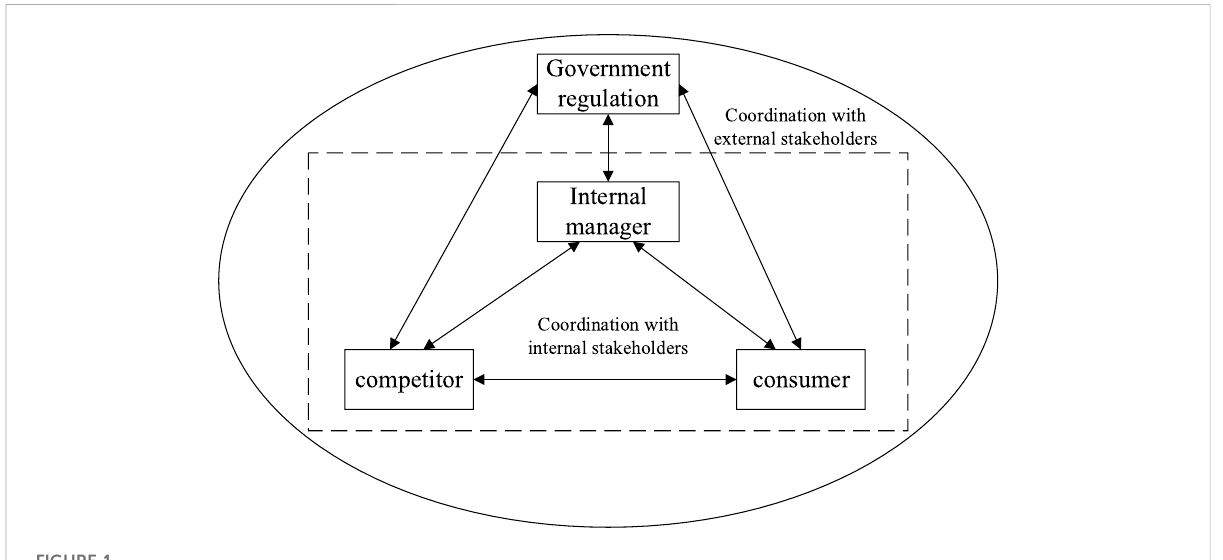
FIGURE 1 A business ecosystem framework map based on internal and external stakeholder in fl